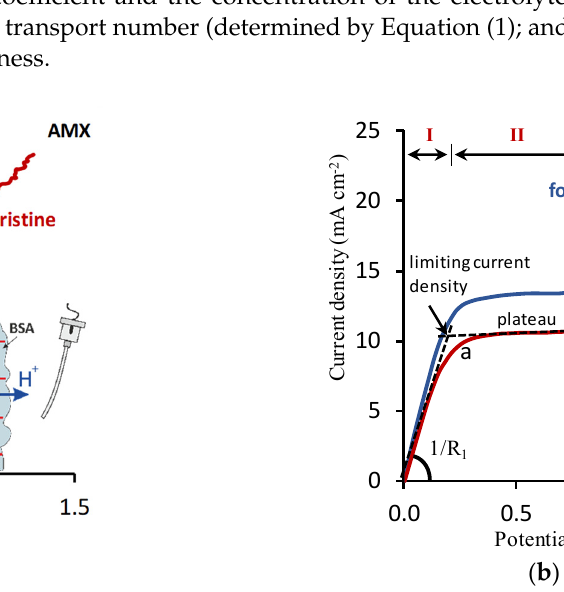
Figure 6. CVC of pristine and fouled by BSA anion exchange AMX ( a ) and cation exchange CMX ( b ) membranes. Insert in ( a ) shows the scheme of the mechanism of water splitting enhancement due to the formation of a bipolar junction between positively charged fixed AMX groups and negatively charged BSA. Explanations can be found in the text. Constructed using data from [146].